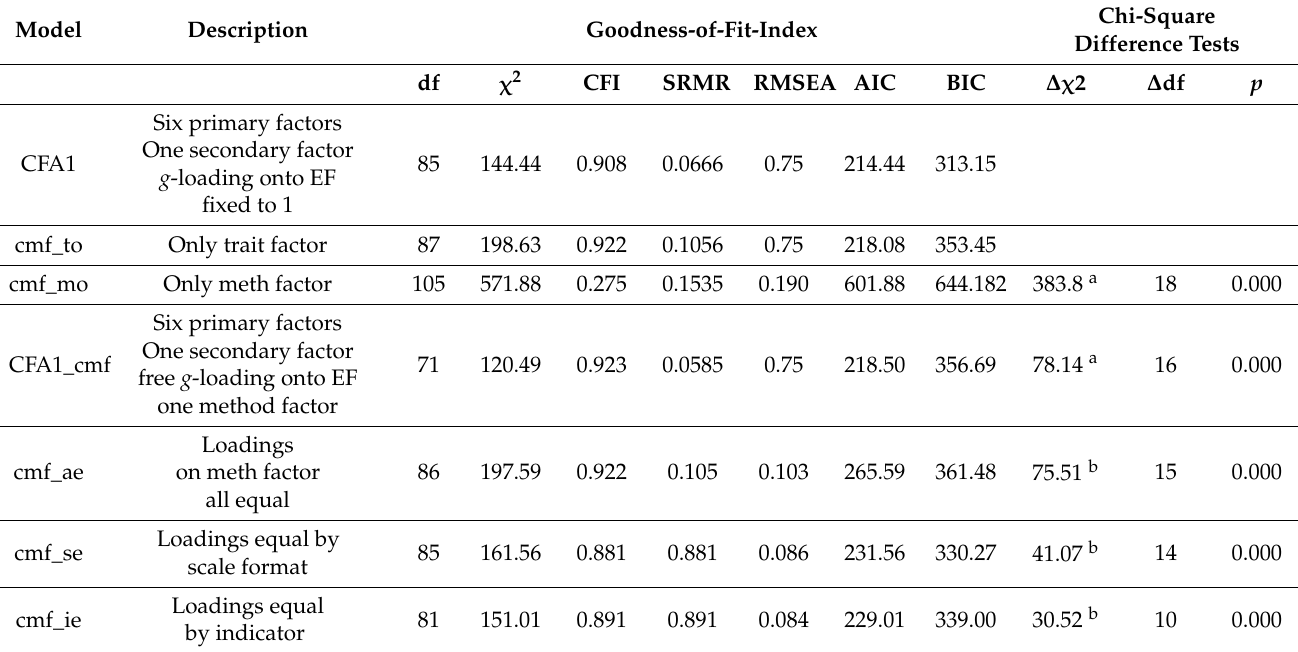
Table 4. Model fit indices of the model comparisons for common method variance with a method